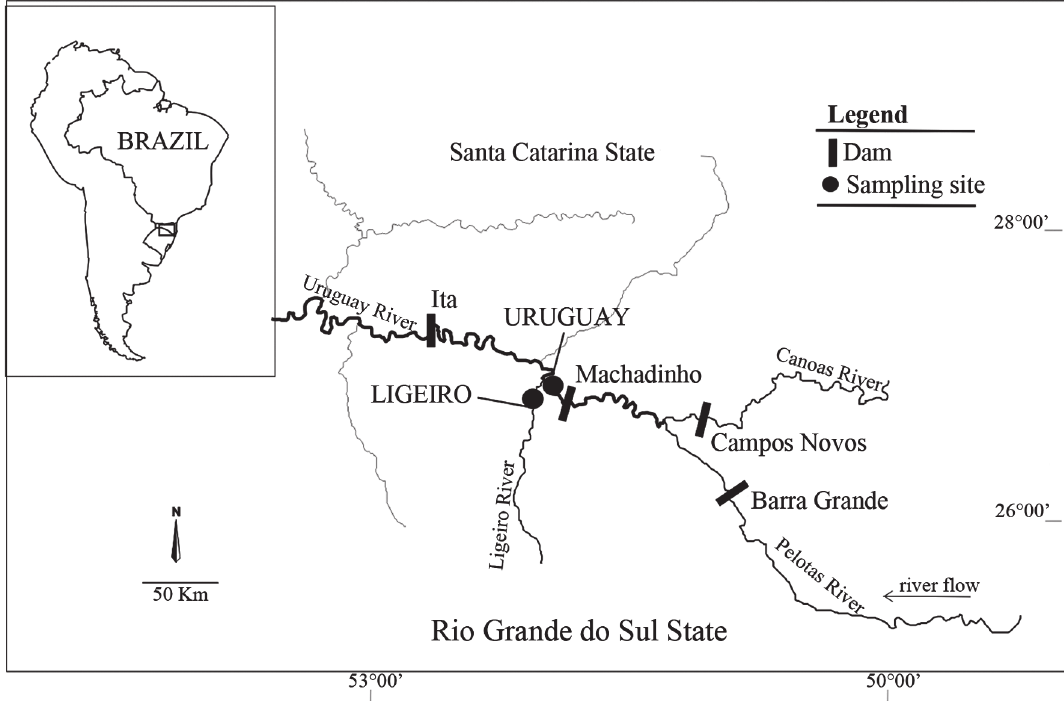
Fig 1. Map of sampling sites location. Uruguay = site in Uruguay River; Ligeiro = site in Ligeiro River.